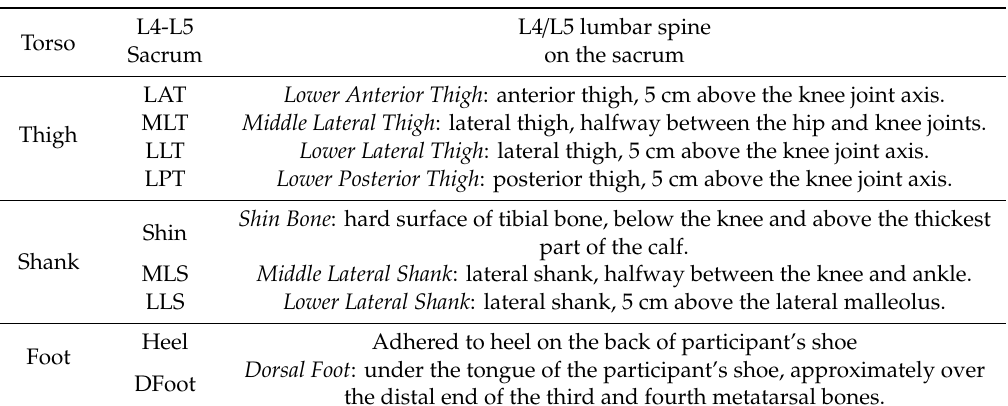
Table 2. Description of the IMU sensor locations on the lower body. L4-L5 L4 / L5 lumbar spine Torso Sacrum on the sacrum LAT Lower Anterior Thigh : anterior thigh, 5 cm above the knee joint axis. MLT Middle Lateral Thigh : lateral thigh, halfway between the hip and knee joints. Thigh LLT Lower Lateral Thigh : lateral thigh, 5 cm above the knee joint axis. LPT Lower Posterior Thigh : posterior thigh, 5 cm above the knee joint axis. Shin Bone : hard surface of tibial bone, below the knee and above the thickest Shin part of the calf. Shank MLS Middle Lateral Shank : lateral shank, halfway between the knee and ankle. LLS Lower Lateral Shank : lateral shank, 5 cm above the lateral malleolus. Heel Adhered to heel on the back of participant’s shoe Foot Dorsal Foot : under the tongue of the participant’s shoe, approximately over DFoot the distal end of the third and fourth metatarsal